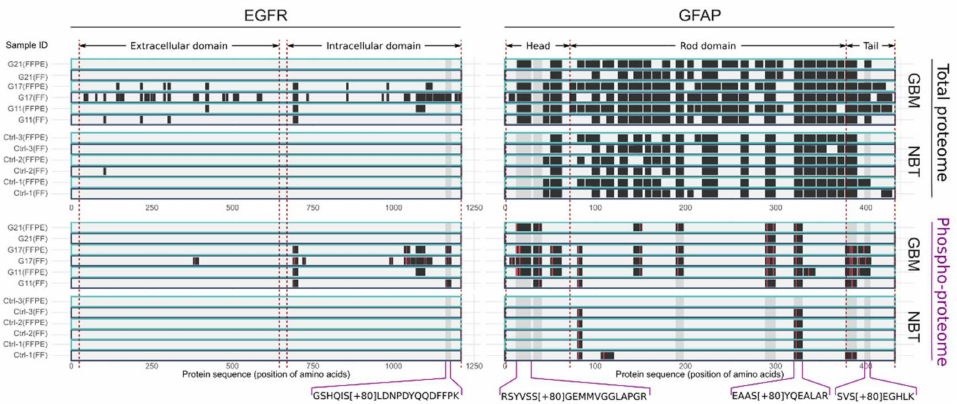
Figure 3. Sequence coverage and phospho-sites of EGFR ( left ) and GFAP ( right ) identified in the total proteome analysis ( top ) and phospho-proteome analysis ( bottom ) of 3 glioblastoma multiforme (GBM) and 3 normal brain tissue (NBT) samples. Results were derived from a publicly available dataset of a previous study (PXD017943). Each sample was prepared and processed in two forms, as fresh frozen tissue (FF, dark blue) and formalin-fixed paraffin-embedded tissue (FFPE, light blue). Dark segments indicate regions covered by peptide identifications, and the red lines mark identified phospho-sites. Gray regions in the sequence mark phospho-peptide targets used for PRM measurements. The four peptides that are annotated at the bottom of the plot were used as epitope-carrying peptide antigens for the Ab–peptide binding